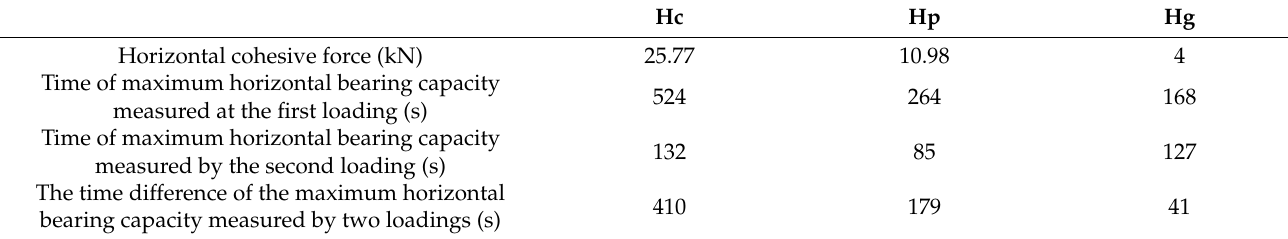
Figure 21. Comparison of the vertical bonding strength of different specimens and the time required to measure the maximum vertical bearing capacity.